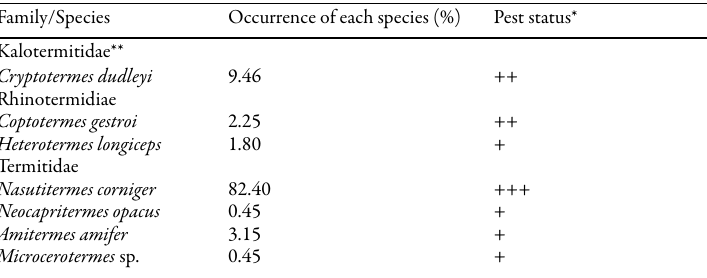
Table 1. Termite species of the urban environment of Recife, NE Brazil. Family/Species Occurrence of each species (%) Pest status* Kalotermitidae** Cryptotermes dudleyi 9.46 ++ Rhinotermidiae Coptotermes gestroi 2.25 ++ Heterotermes longiceps 1.80 + Termitidae Nasutitermes corniger 82.40 +++ Neocapritermes opacus 0.45 + Amitermes amifer